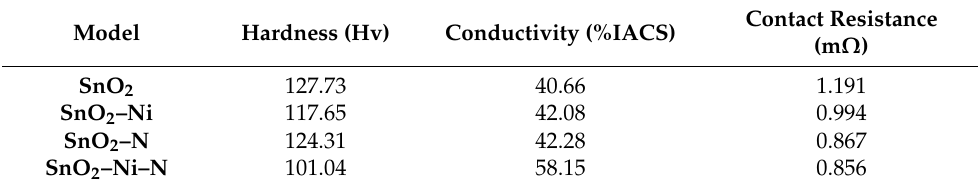
Table 7. Experimental results of hardness, conductivity and contact